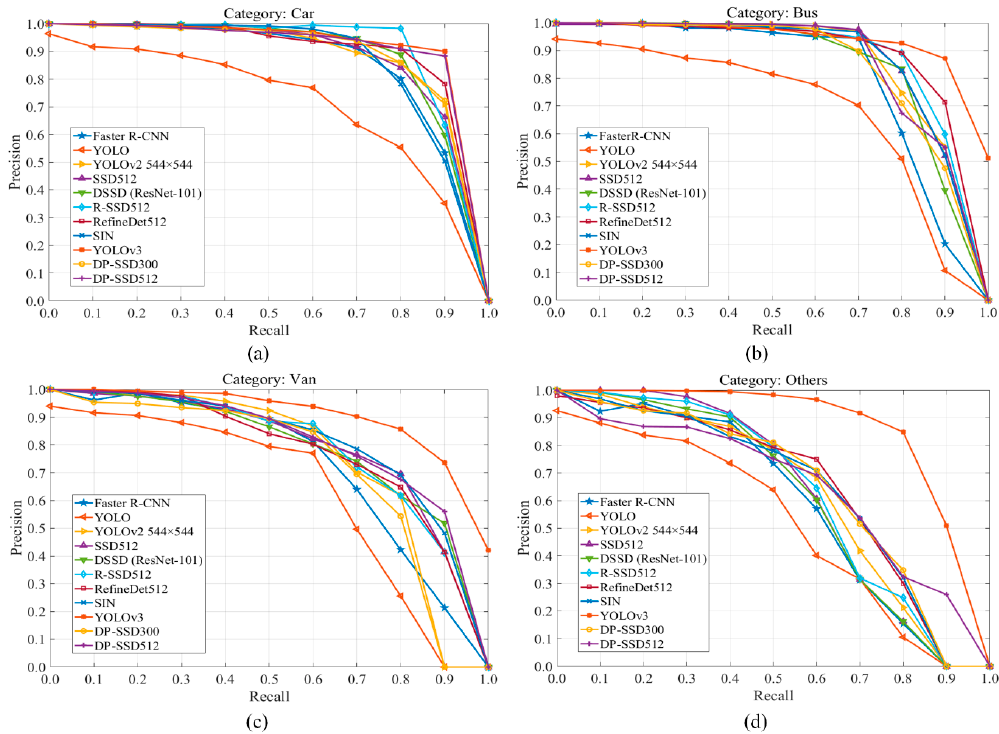
Figure 5. Precision-recall curves between different methods on UA-DETRAC dataset over four Figure 5. Precision ‐ recall curves between different methods on UA ‐ DETRAC dataset over four categories of car, bus, van, and others. ( a ) Precision ‐ recall curves for the car category; ( b ) Precision ‐ categories of car, bus, van, and others. ( a ) Precision-recall curves for the car category; ( b ) Precision-recall curves for the bus category; ( c ) Precision-recall curves for the van category; ( d ) Precision-recall curves for the others category.